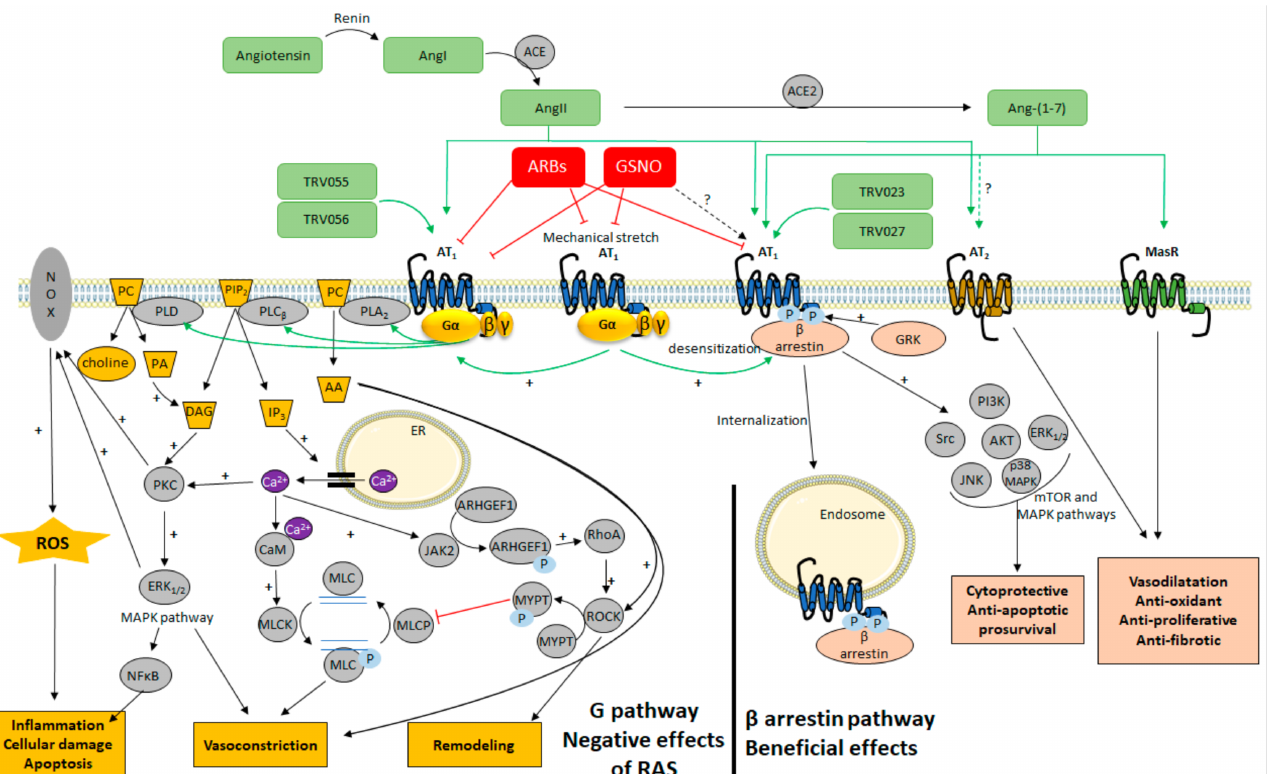
Figure 3. Overview of the cellular signaling pathways activated by AT 1 after stimulation of the renin–angiotensin system (RAS). AA: arachidonic acid; ACE: angiotensin-converting enzyme; ACE2: angiotensin-converting enzyme 2; AKT: protein kinase B; Ang-(1–7): angiotensin (1–7); Ang I: angiotensin I; Ang II: angiotensin II; ARHGEF1: Rho guanine nucleotide exchange factor 1. AT 1 : angiotensin II type 1 receptor; AT 2 : angiotensin II type 2 receptor; ARBs: angiotensin receptor blockers; CaM: calmodulin; DAG: diacylglycerol; ER: endoplasmic reticulum; ERK 1/2 : extracellular signal regulated kinase 1 ; GRK: G protein-coupled receptor kinase; GSNO: S-nitrosoglutathione; IP 3 : inositol triphosphate; JAK2: Janus kinase 2; 2 JNK: c-Jun N-terminal Kinase; MAPK: mitogen-activated protein kinases; MasR: Mas receptor; MLC: myosin light chain; MLCK: myosin light chain kinase; MLCP: myosin light chain phosphatase; mTOR: mammalian target of rapamycin; MYPT: myosin phosphatase target subunit; NF κ B: nuclear factor kappa B; NOX: NADPH oxidase; PA: phosphatidic acid; PC: phosphatidylcholine; PI3K: phosphoinositide 3 kinase; PIP 2 : phosphatidylinositol-4, 5-diphosphate; PLA 2 : phospholipase A2; PLC β : phospholipase C β ; PLD: phospholipase D; PKC: protein kinase C; RhoA: RAS homolog family member A; ROCK: Rho associated protein kinase; ROS: reactive oxygen species; TRV023 and TRV027: β -arrestin biased AT 1 agonists; TRV055 and TRV056: G q biased AT 1 agonists. The figure was prepared in part with the Servier Medical Art website (Creative Commons Attribution 3.0 unported